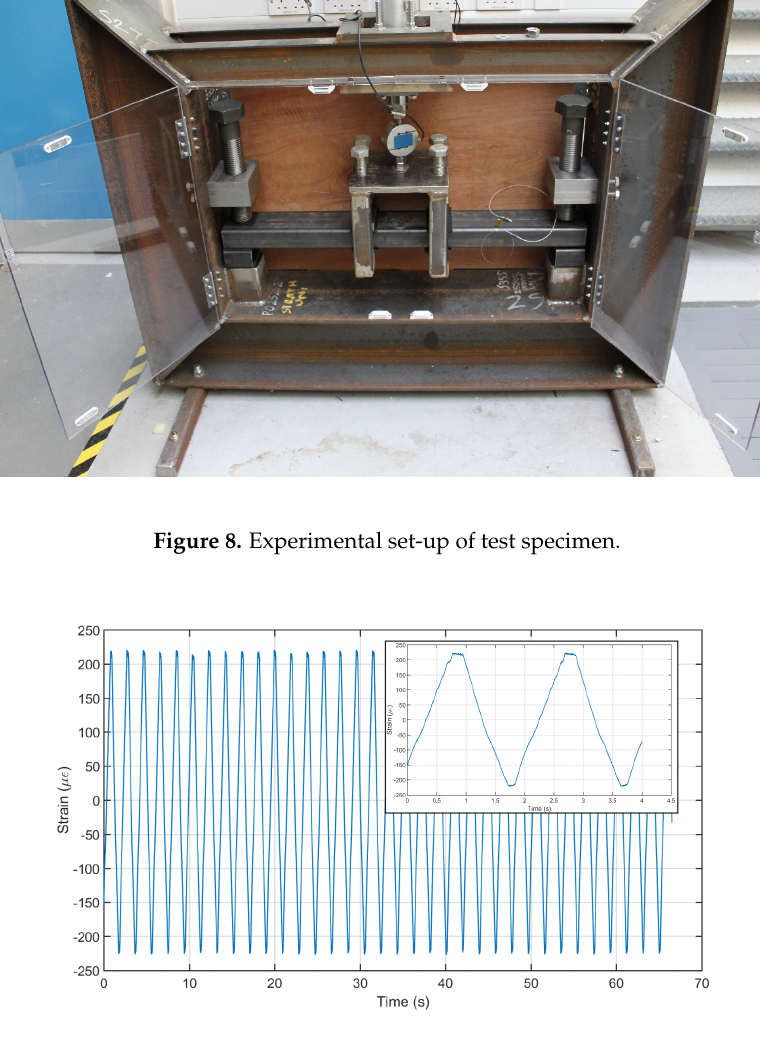
Figure 9. Strain at centre of steel beam, insert: detailed view of